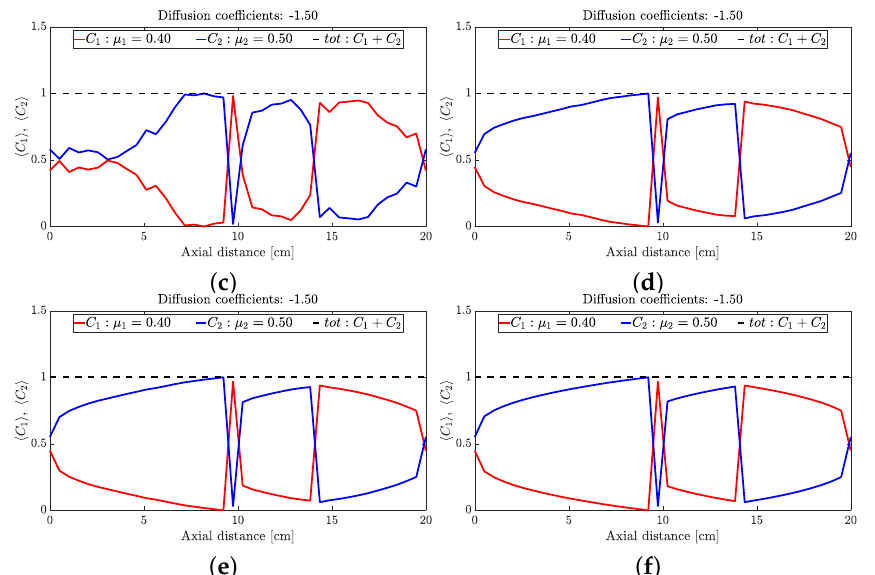
Figure 2. Snapshots of binary mixture at: ( a ) 0 s, ( b ) 17 s, ( c ) 50 s, ( d ) 500 s, ( e ) 1000 s and ( f ) 5000 s with a fixed diffusion coefficient of −